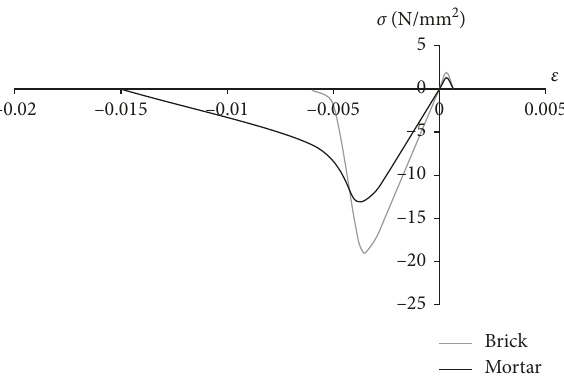
Figure 10: Assumed stress-strain behavior for brick and mortar.